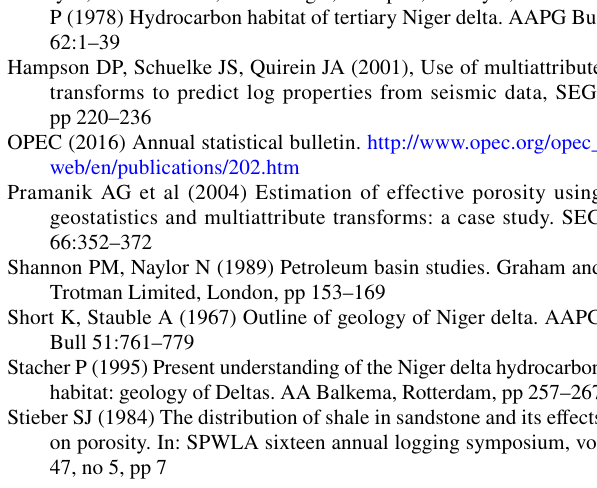
Fig. 18 Volume of shale time slice at top of reservoir 2